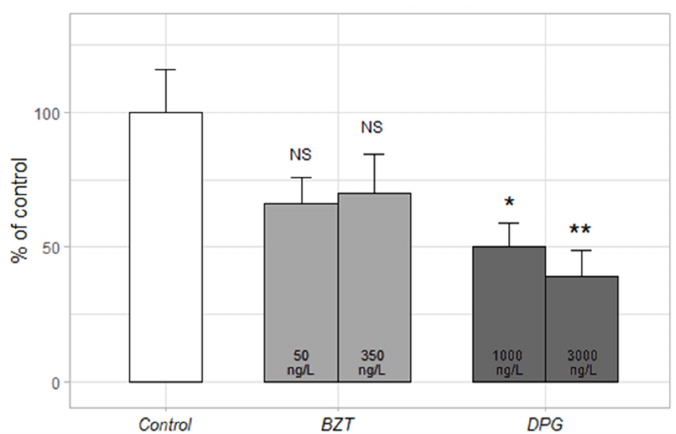
Figure 8. Inhibition of complex I of the mitochondrial respiratory chain by BZT) and DPG at the indicated concentrations. Difference compared to control * = p -value < 0.05, ** = p -value < 0.01 (non- parametric Kruskal–Wallis test); NS = not significant.